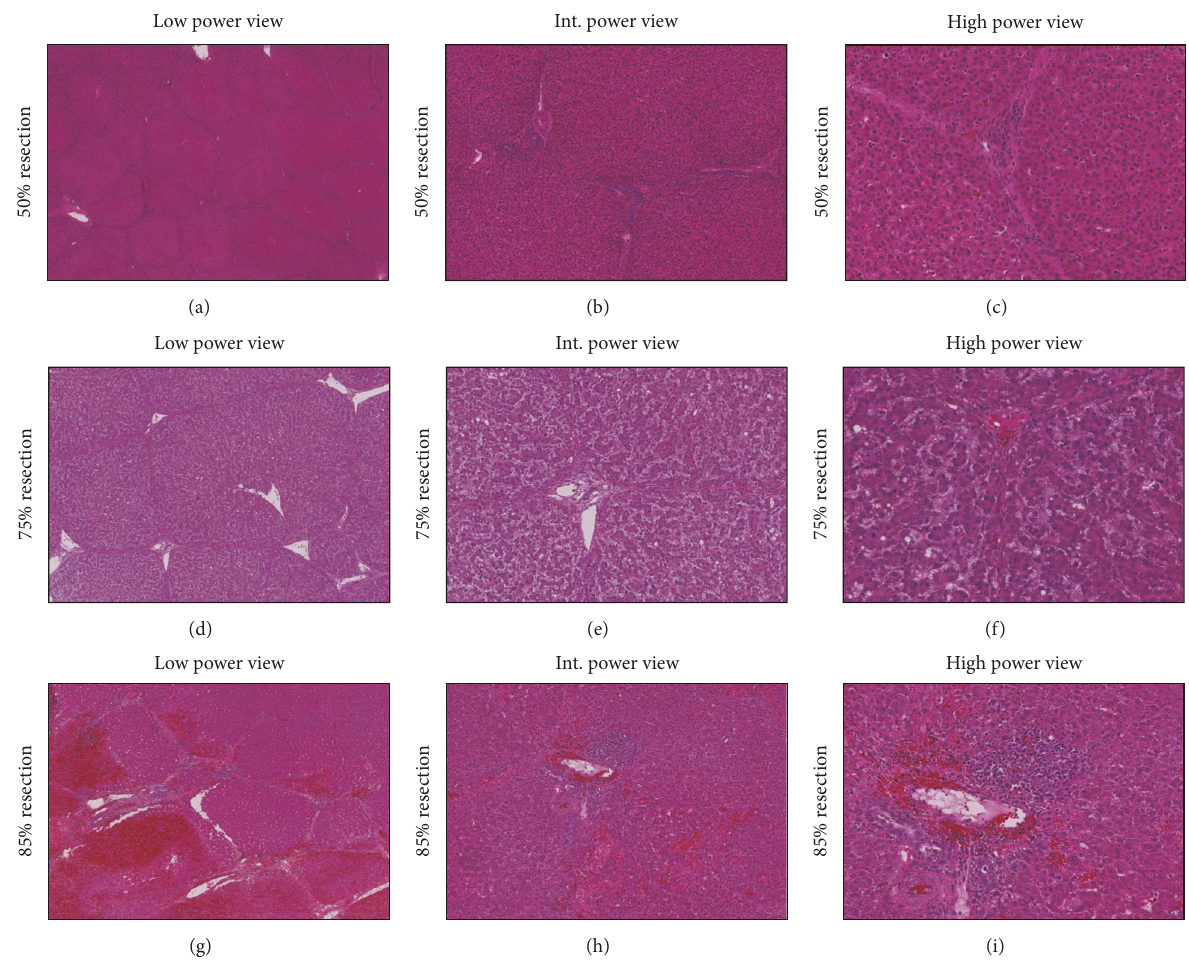
Figure 5: Composite of liver biopsies of 50%, 75%, and 85% liver resection at the time of sacrifice with low (a, d, and g), intermediate (b, e, and h), and high power view (c, f, and i). The low power view shows no significant change in 50% hepatectomy group. Normal hepatocytes and unchanged hepatic structures are seen (a). In the high power views only few mitoses are seen ((b) and (c)). The low power view of liver after 75% liver resection is shown in (d). Portal and periportal edema and significant elevated mitoses are prominent findings in 75% hepatectomy group ((e) and (f)). The low power view of 85% resection reveals extensive hemorrhage (g). Necrosis, bleeding, and inflammation in periportal area are shown in high power view (h and i). Int.: